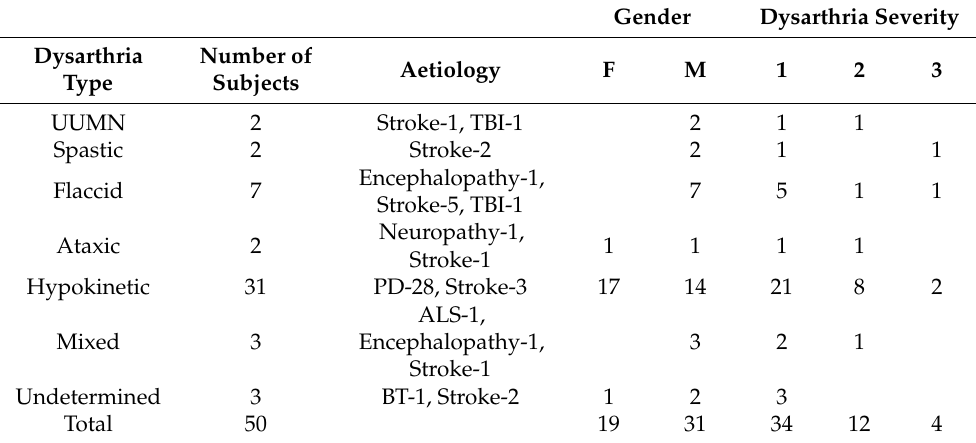
Table 1. Characteristics of the selected Dutch speakers.